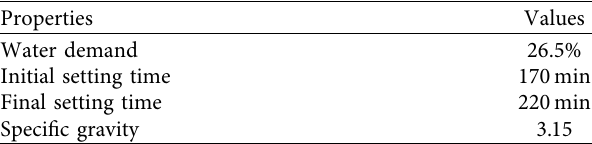
Table 1: Physical properties of